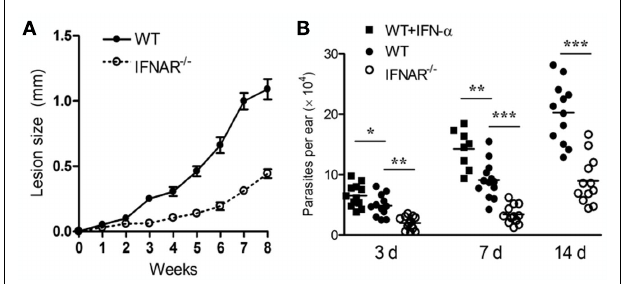
FIGURE 1 |The IFNAR signaling promotes L. amazonensis infection in mice. (A) IFNAR − / − mice developed smaller lesions that contained lower parasite loads than did wild-type controls. (B) The infection-promoting effect of IFN-a was detectable at 3days post-infection.The lack of IFNAR signaling restrained parasite infection at early stages of the infection. Adapted from Xin et al.